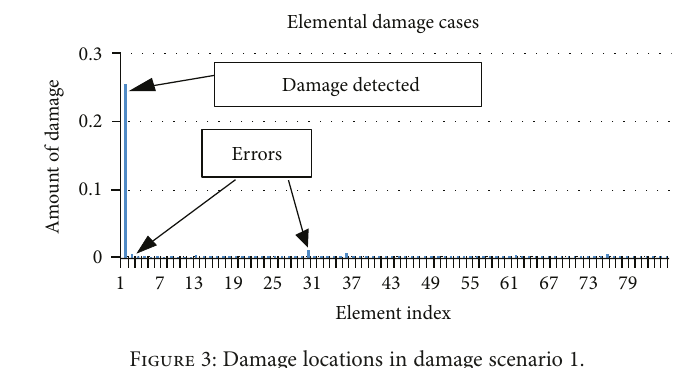
Figure 3: Damage locations in damage scenario 1.